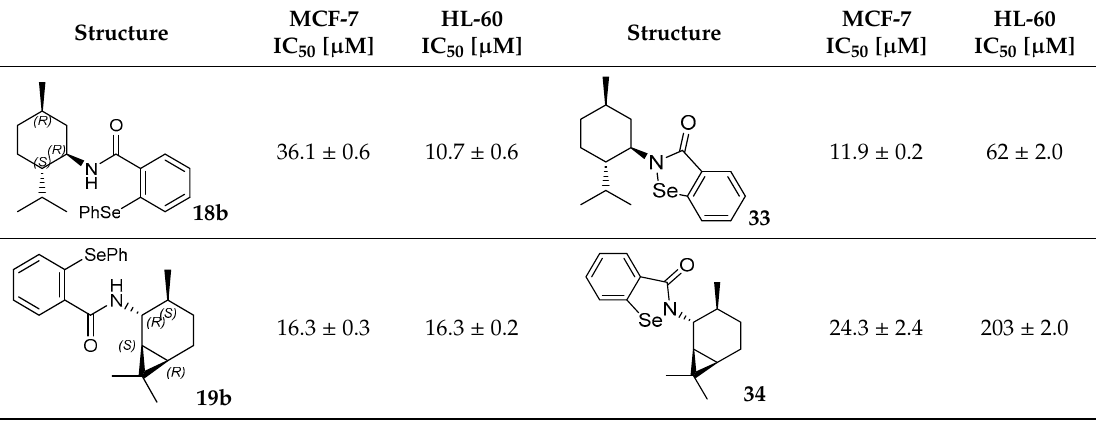
Table 1. Cytotoxic activity of N -terpene derivatives and the corresponding benzisoselenazol-3(2 H )-ones. Structure